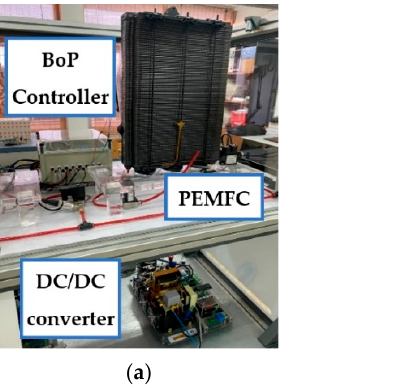
Figure 9. Details of the PEM fuel cell module (a) and datasheet characteristics(b).